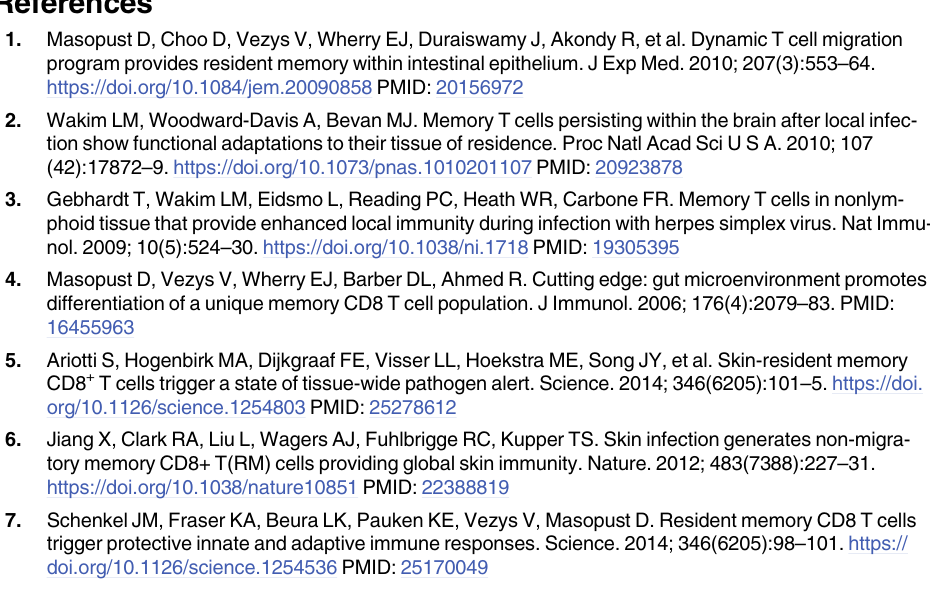
based on fold change, where the most up-regulated genes in the TGF- β -treated group are on the far left and the most down-regulated genes on the far right. The dotted vertical grey line represents fold change of zero. The curved lines, colored by TCM or TEM, show the cumula- tive enrichment score. The dots denote the positions in the ordered ranked list where the genes in each gene set appear. Of note, the TCM-related downregulated gene set was not tested for enrichment since it did not achieve the minimum gene set size of N =